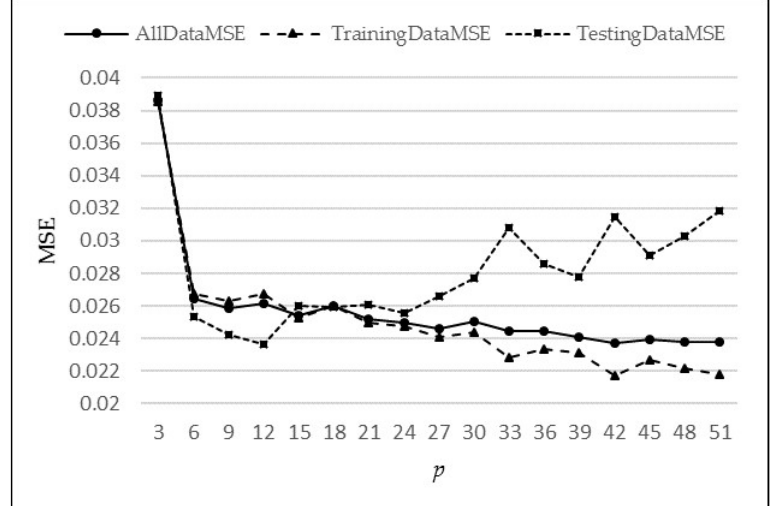
Figure 8. MSE vs. Lags for synthetic data.